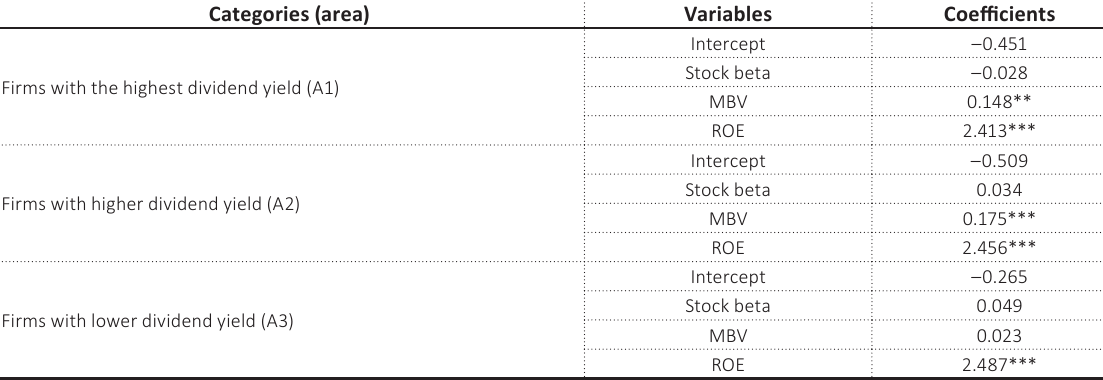
Table 2. Results of multinomial